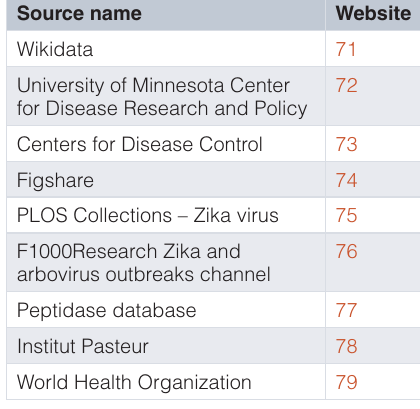
Table 1. A list of data sources and repositories for Zika virus